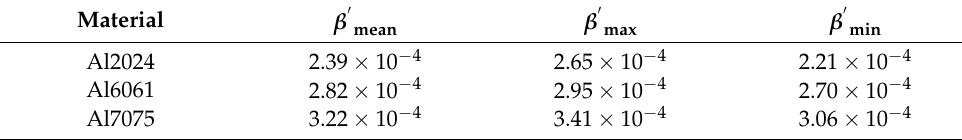
Table 3. Measurement results of the relative nonlinear parameter β (cid:48) .